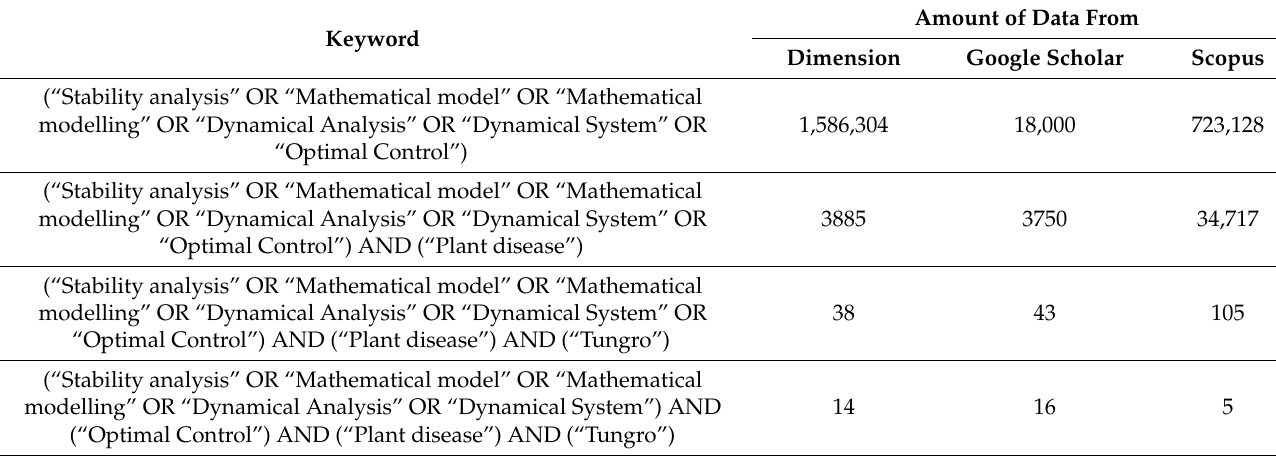
Table 1. Search results through the